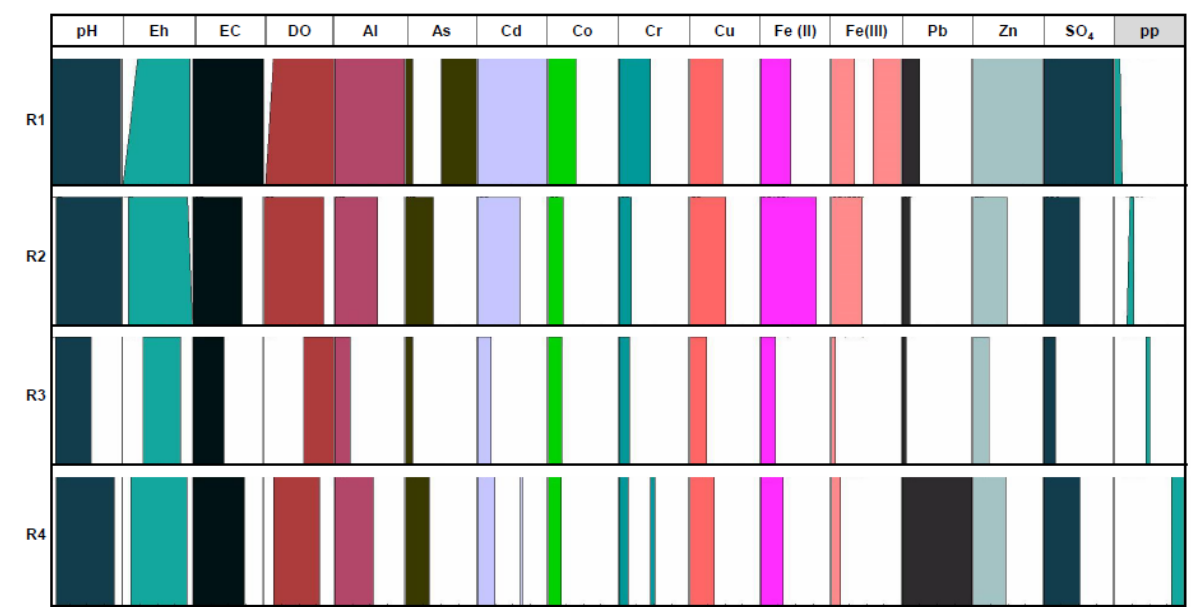
Figure 5. Fuzzy rules taking the accumulated rainfall over 30 days prior to sampling as the consequent.